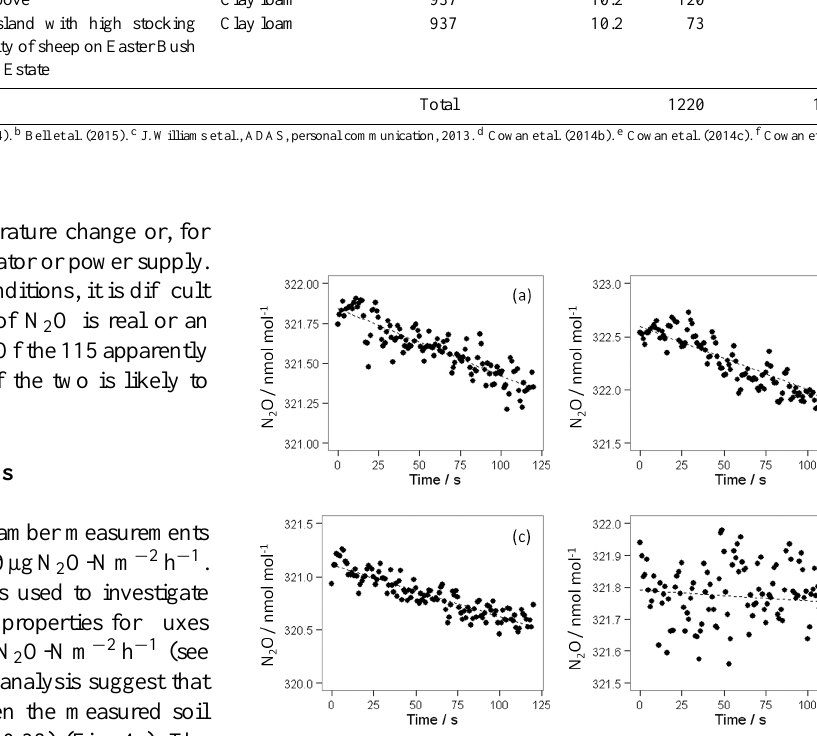
Figure 3. Examples of 1Hz N 2 O mixing ratio data recorded during four separate negative flux measurements made using the dynamic chamber method. Each flux measurement uses over 120 individual measurements to calculate the rate of change of N 2 O mixing ratio within the chamber over a 3min measurement period. (a, b, c) are examples of clear and consistent negative fluxes; (d) is an example of negative flux likely attributable to instrumental